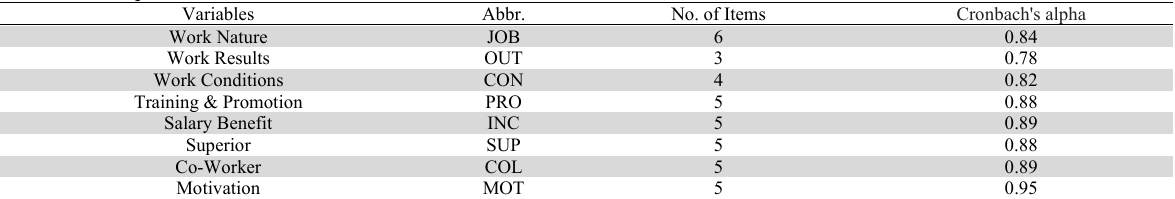
Cronbach’s Alpha of the Variables